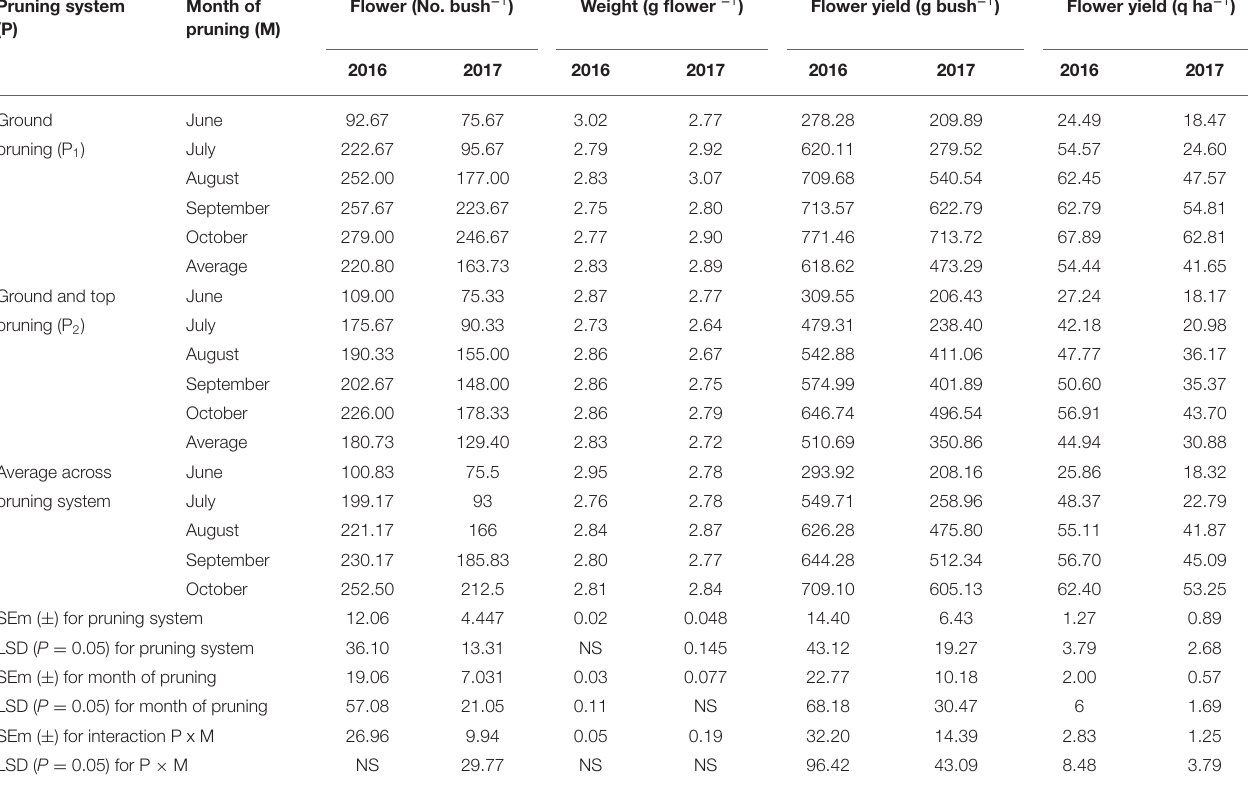
TABLE 1 | Yield attributes and flower yield of Rosa damascena in response to pruning system (P) and month of pruning (M). Pruning system